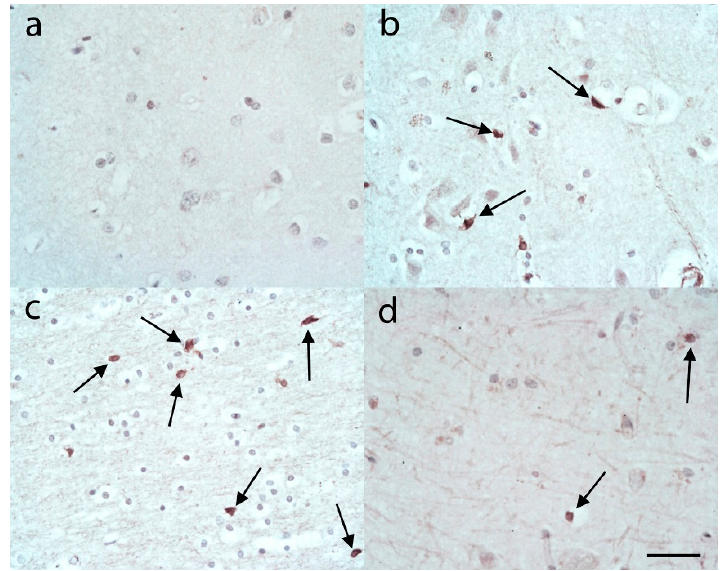
Figure 1. C3 immunohistochemistry in control cases revealed very few or no astrocyte-like cells (ASLCs) in the upper frontal cortex ( a ). There were, however, often moderate or sometimes abundant ASLCs present in the lower frontal cortex ( b , arrows) and frontal white matter ( c , arrows). Occasional ASLCs were seen in the CA4 region of the hippocampus ( d , arrows). Anti-C3d. Original magnifications ( a )–( d ) × 40 (numerical aperture (NA) 0.9). Scale Bar ( a )-60 µm, ( b )–( d ) − 50 µm